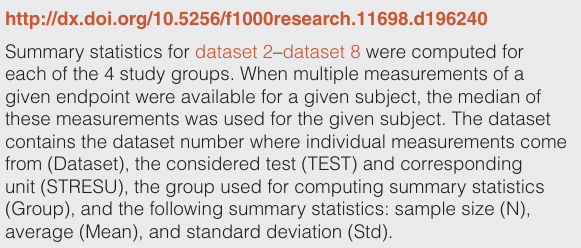
Dataset 9. Basic Summary Statistics